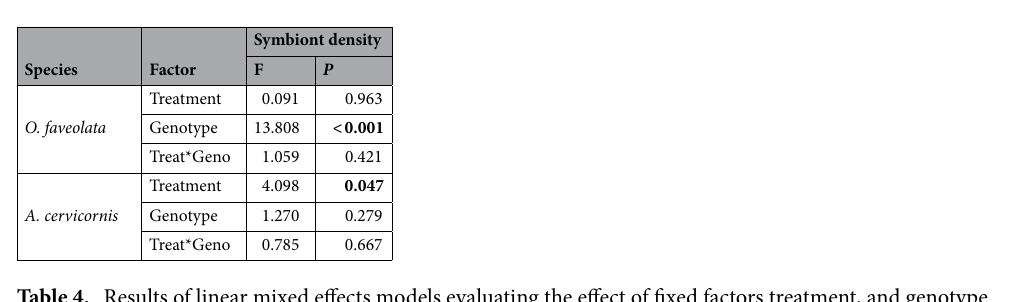
Table 4. Results of linear mixed effects models evaluating the effect of fixed factors treatment, and genotype on coral symbiont density. Significance at P < 0.05 is noted in